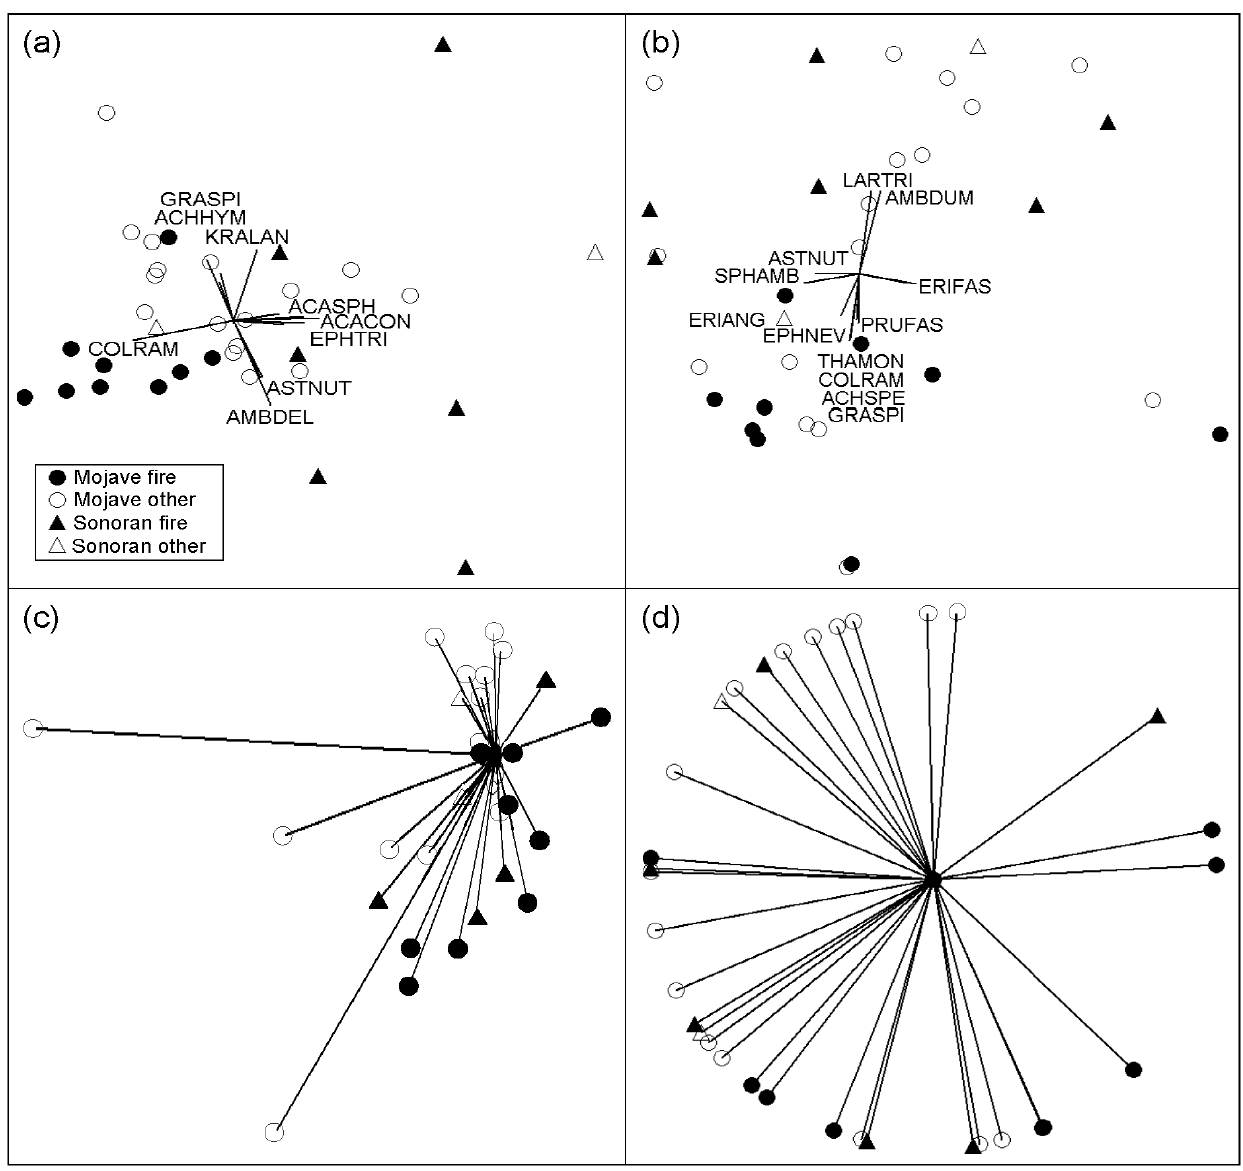
Figure 4. Illustration of species composition patterns among studies examining post-disturbance plant recovery in the Mojave and Sonoran Deserts of the American Southwest. Studies are distinguished by desert and disturbance type (fire or land-clearing disturbances such as old roads). (a) Undisturbed vegetation, where species are shown as vectors. Vector lengths and directions indicate correlations with different study groupings. Only species exhibiting an r 2 ≥ 0.15 are shown. Species are abbreviated as the first three letters of the genus and species given in Table 4, and for four species in (a) and (b) not given in Table 4, as ACACON = Acacia constricta , ASTNUT = Astragalus nuttallianus , EPHTRI = Ephedra trifurca , and ERIANG = Eriodictyon angustifolium . (b) Disturbed vegetation. (c) Successional vectors showing the difference between disturbed and undisturbed species composition of each study, where increasing lengths of vectors represent greater differences. (d) Successional vectors standardized to unit length, comparing the direction of species compositional change among